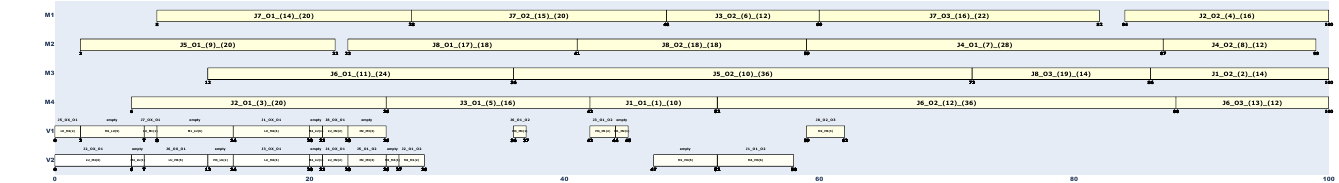
Figure 8. Gantt chart for improved solution of EX_730 instance from Kumar, Janardhana and Rao [11].